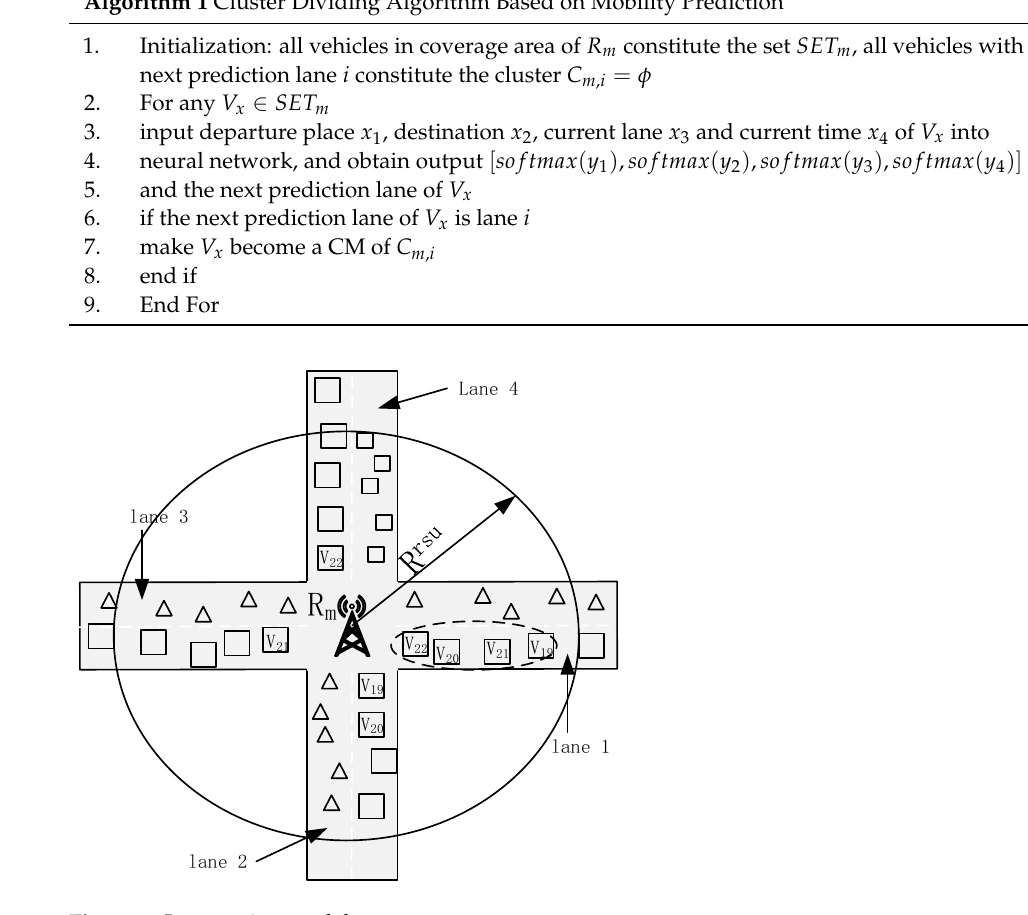
Figure 6. Intersection model.